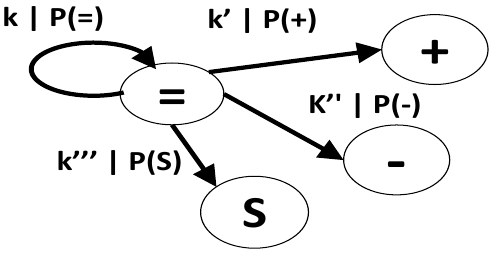
Figure 26. Automaton defining the next bet